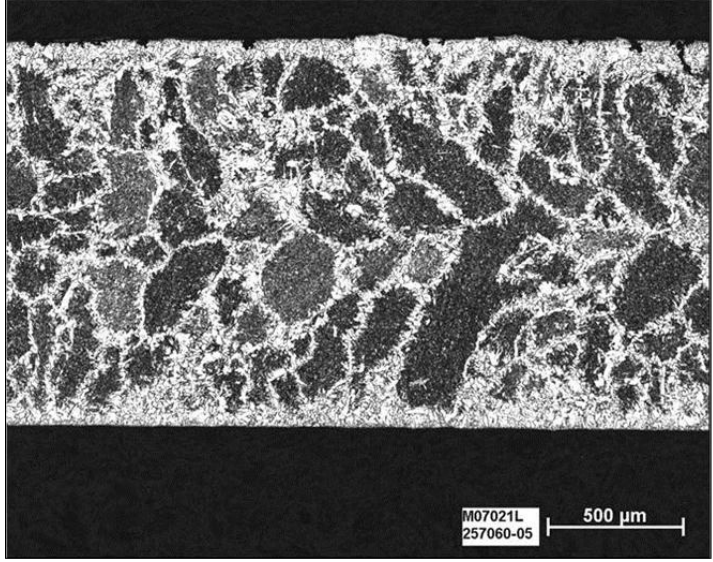
Figure 2. Prior austenite grains are clearly delineated with proeutectoid ferrite in a production CASTRIP, Base grade.